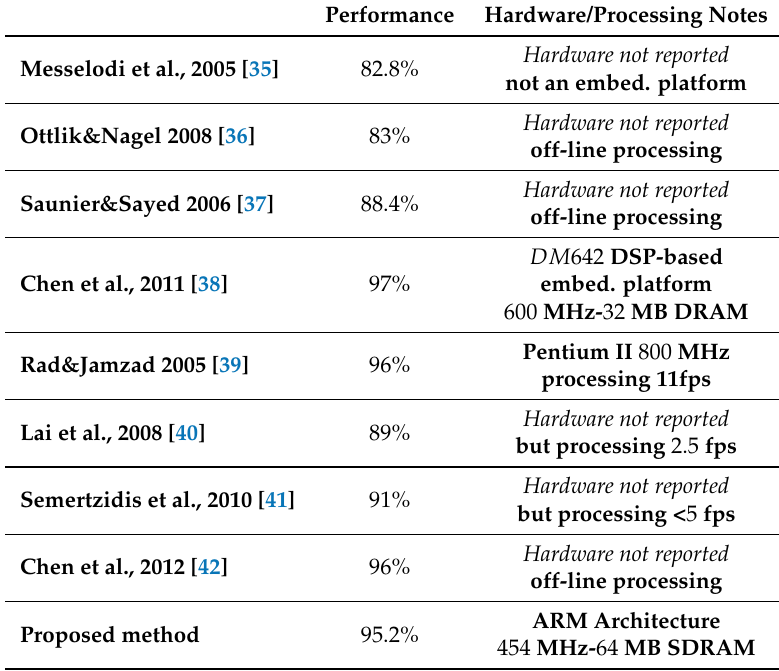
Table 5. Comparison of performances and computational power for different